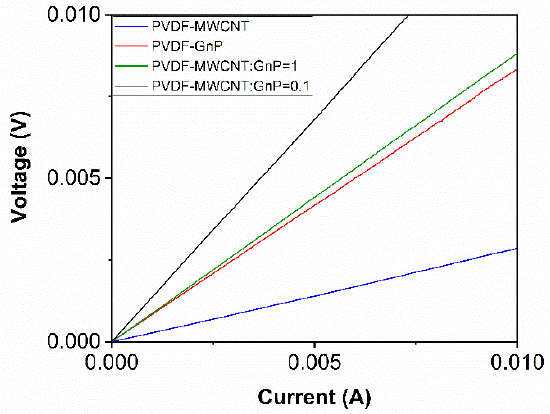
Figure 2. The voltage-current relationship of PVDF nanocomposite samples loaded with about 1.4 wt.% of various carbon nanofillers.